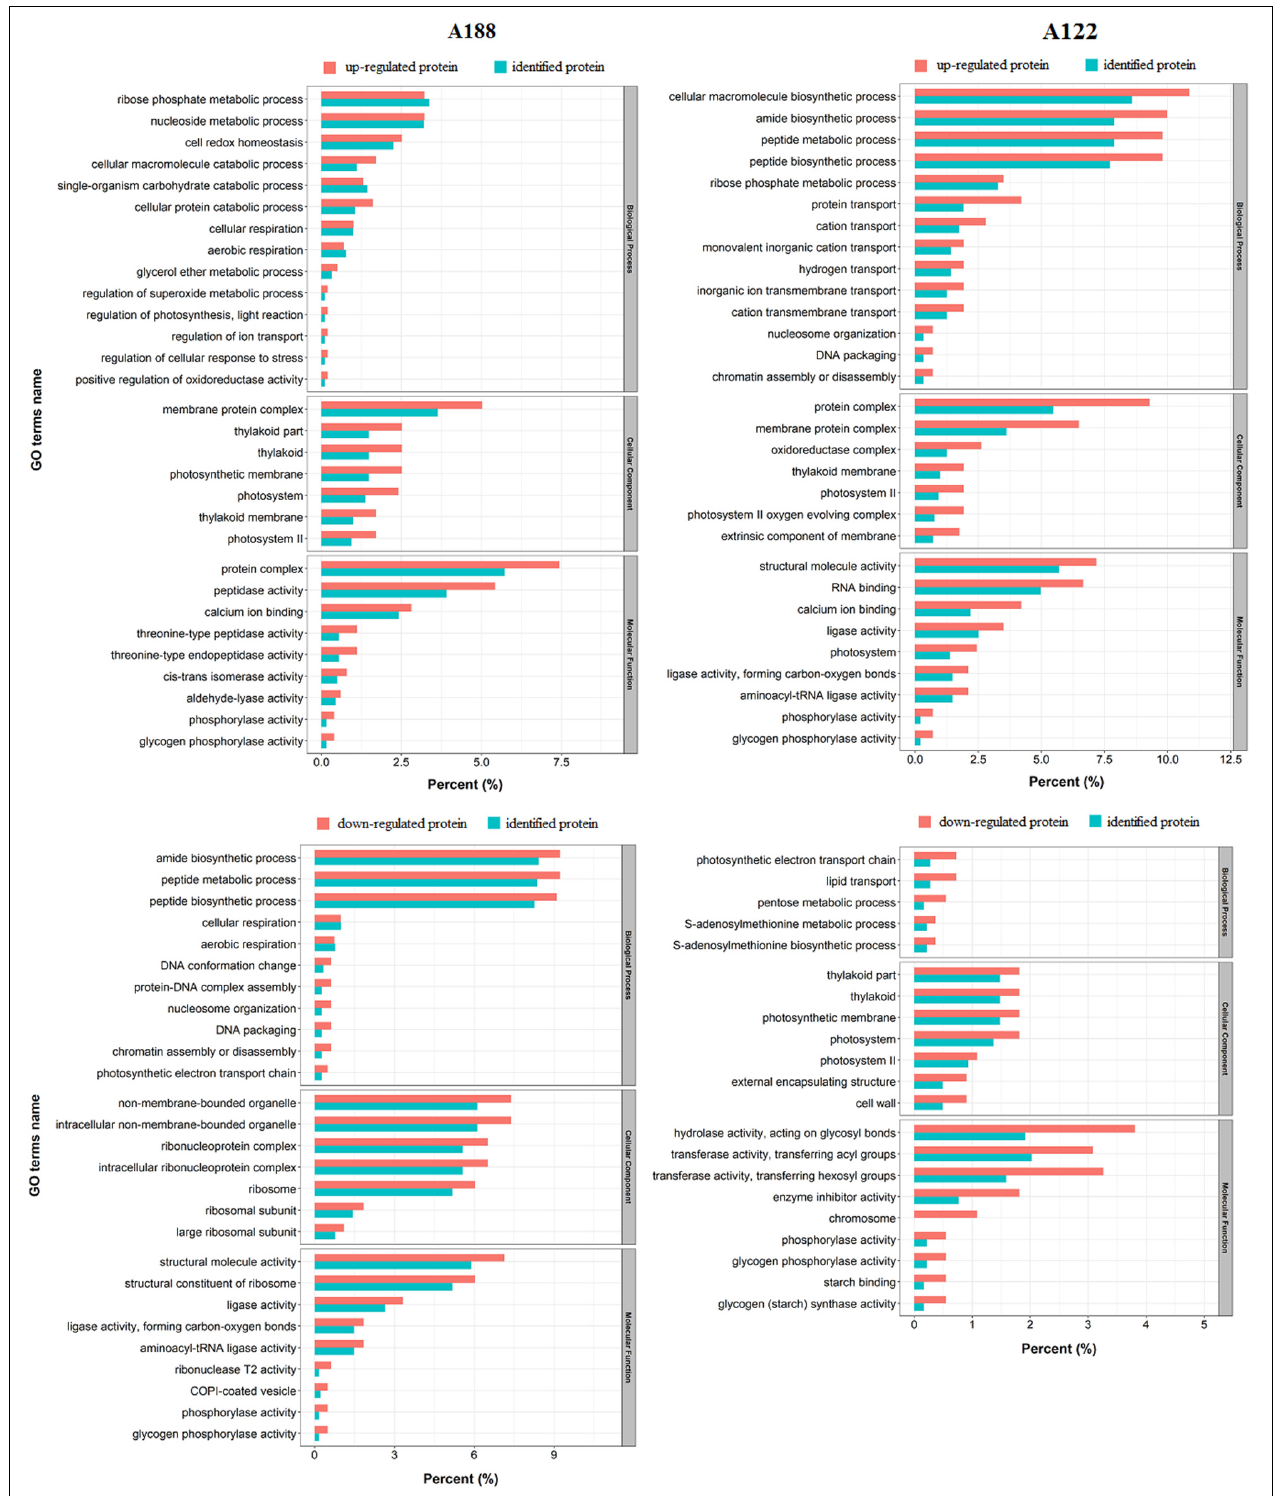
FIGURE 5 | Functional enrichment analysis between the upregulated and downregulated proteins in co-identified proteins. The percentage of differentially expressed proteins indicates the ratio of the mapping proteins to all mapping proteins. The percentage of identified proteins indicates the ratio of the background proteins to all background